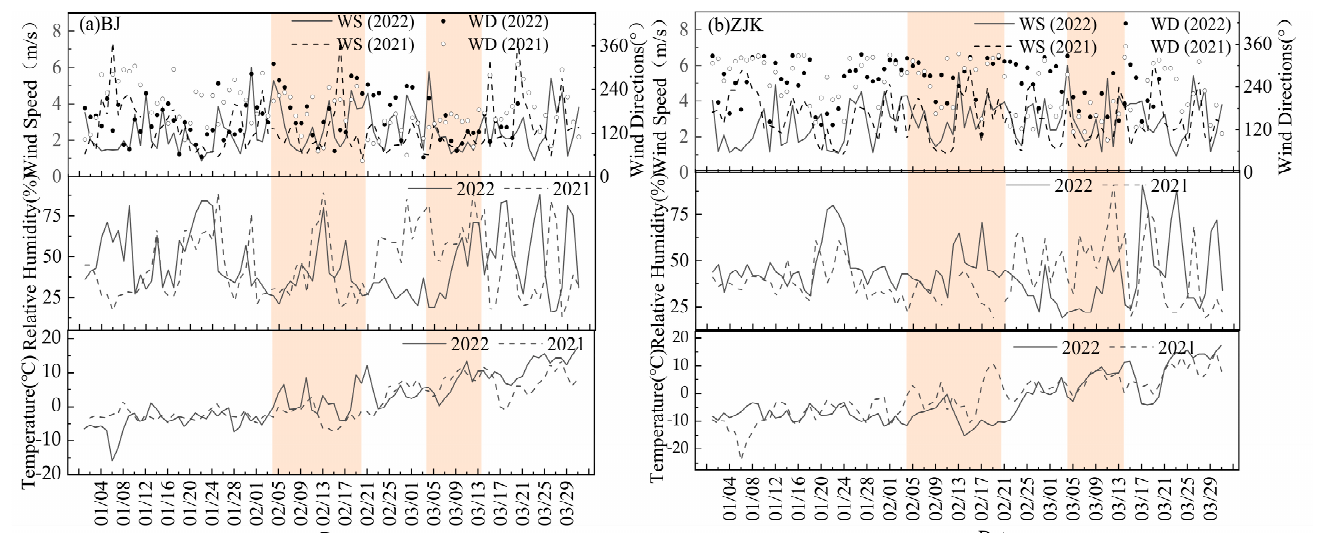
Figure 5. Meteorological conditions DWO compared with those during the same period in 2021. ( a ) Beijing ( b ) Zhangjiakou.